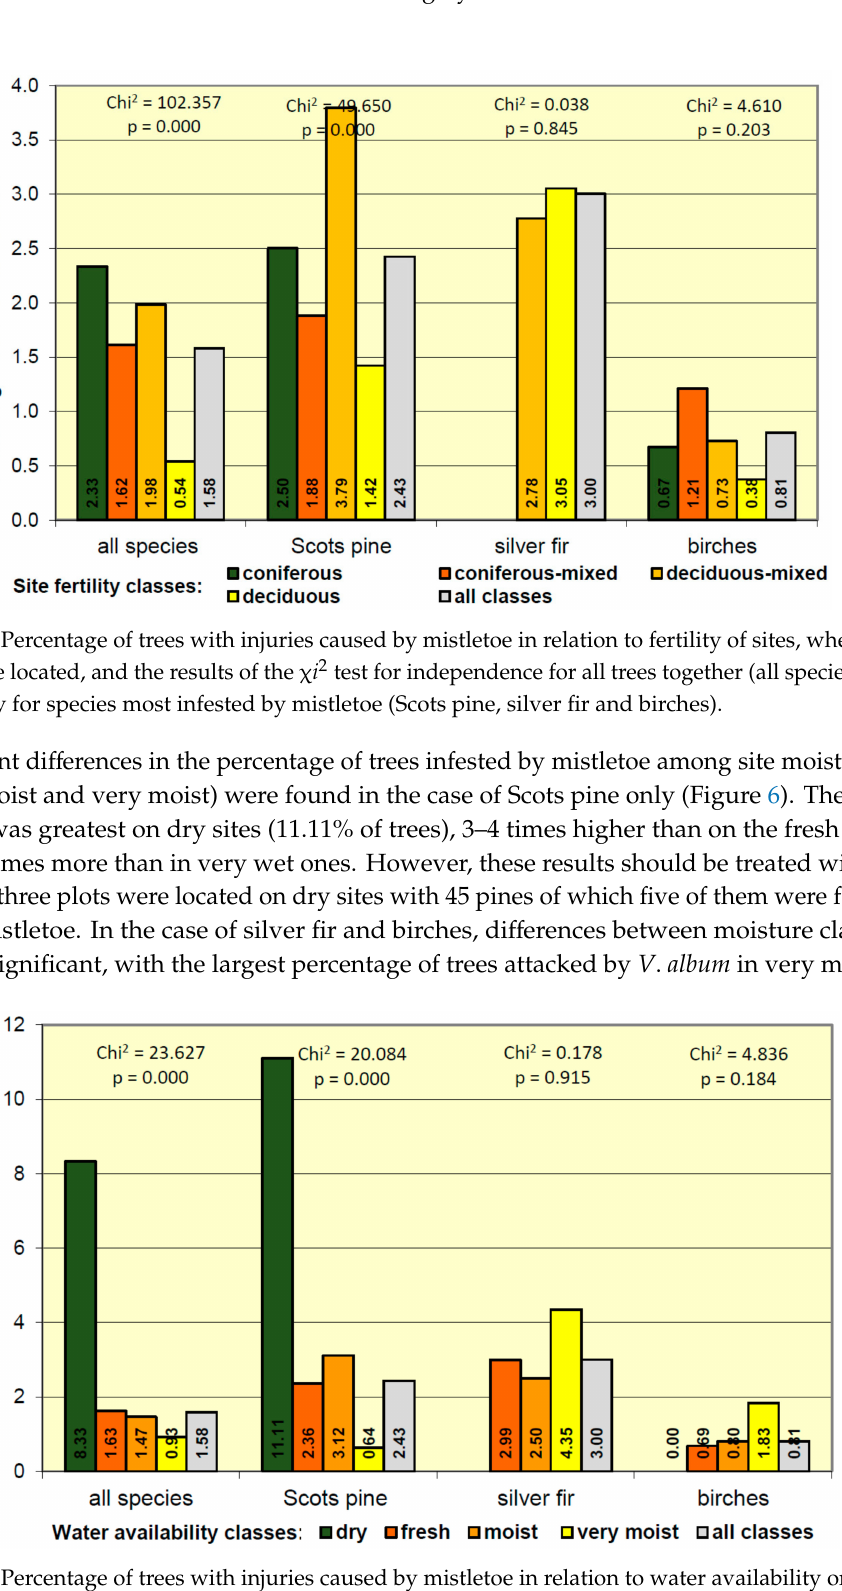
Figure 6. Percentage of trees with injuries caused by mistletoe in relation to water availability on sites, where the plots were located, and the results of the χ 2 test for independence for all trees together (all species) and separately for species most infested by mistletoe (Scots pine, silver fir, and